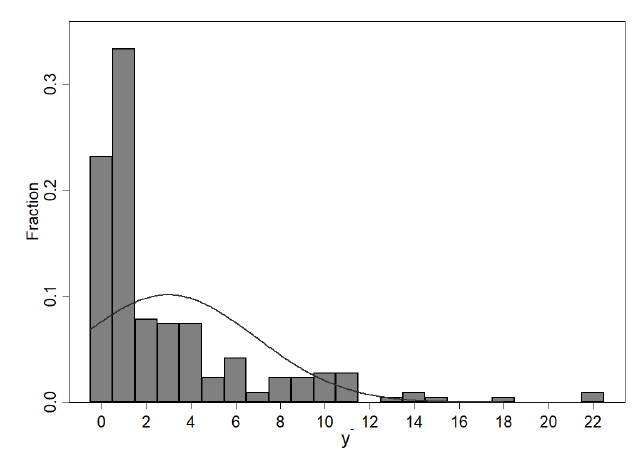
Figure 3. Distribution of average downward adjusted offer y −